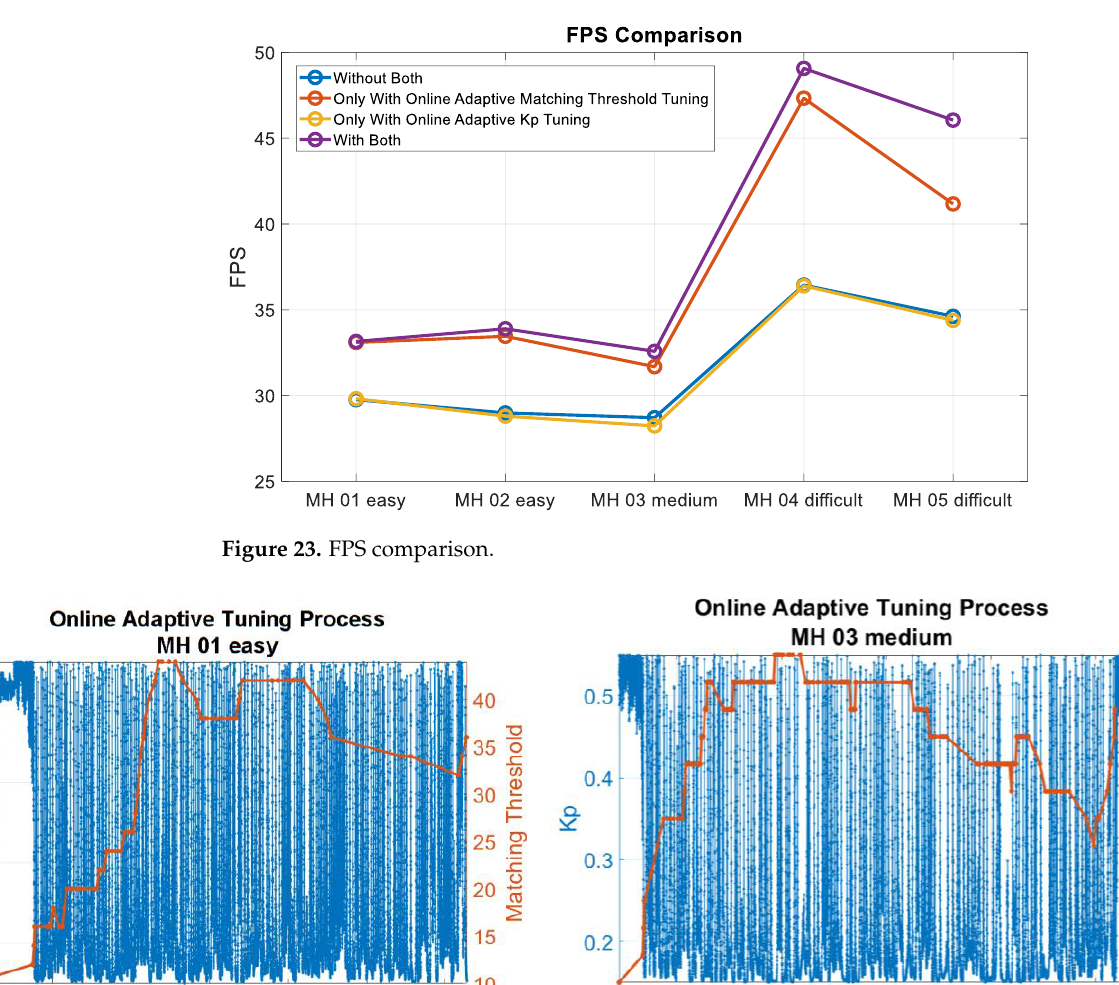
Table 6. Computer s pecifications used for the proposed algorithm.